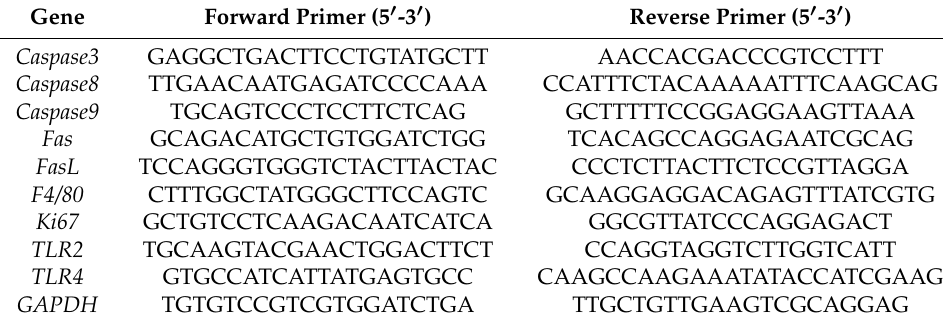
Table 2. Primers used for real-time